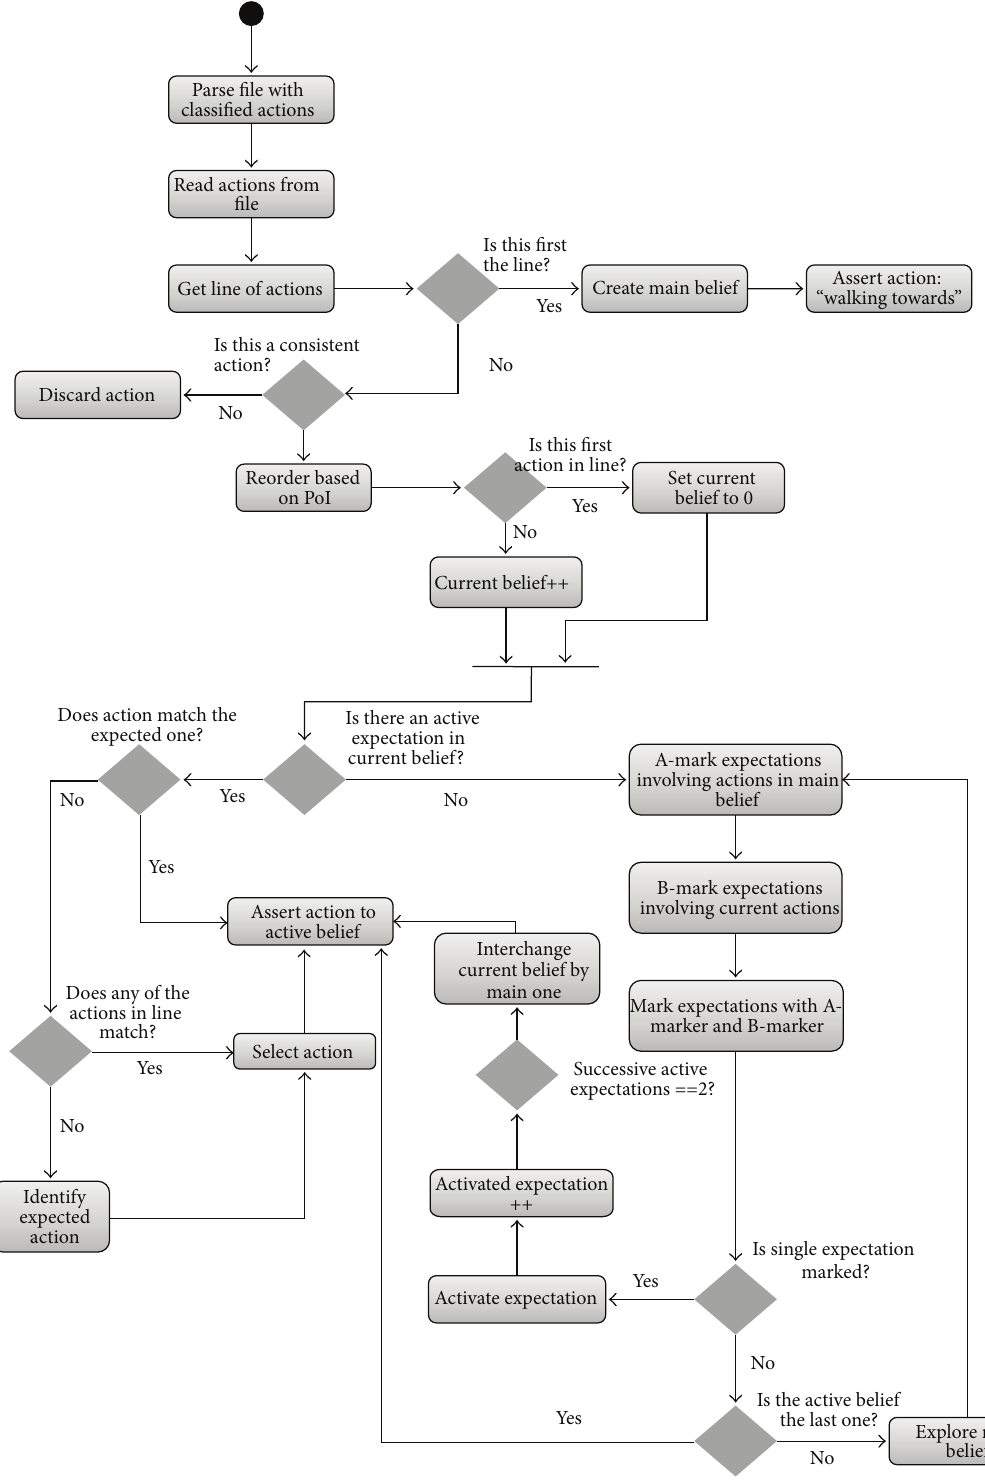
Figure 5: Activity diagram for reasoning about human